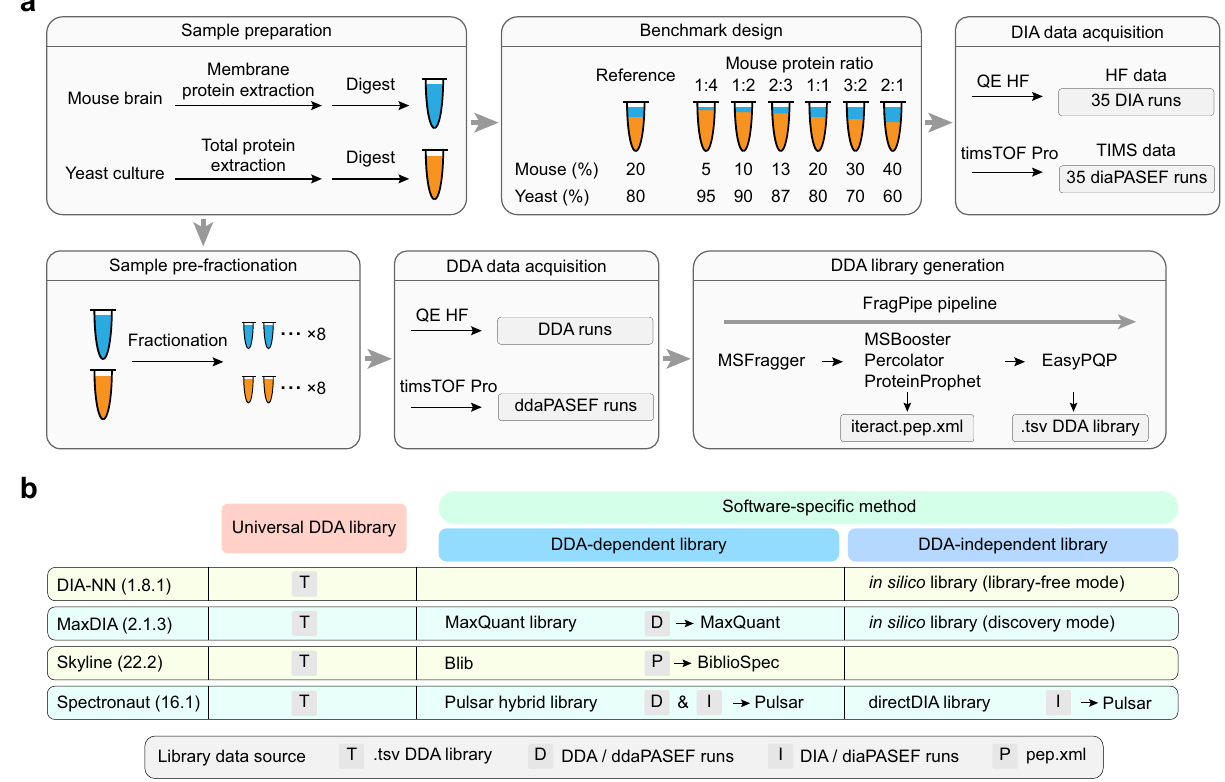
Fig. 1 | Schematic of the benchmarking experiment and DIA data analysis work fl ows.a Work fl ow of the benchmarking experiment. Mouse brain membrane protein digests were spiked into a yeast proteome background in seven de fi ned proportions, yielding one reference and six mixtures with fi xed mouse protein ratios relative to the reference. For each sample prepared in fi ve replicates, DIA benchmarkdatawereacquiredonQEHFandtimsTOFProinstruments.Meanwhile DDA data were acquired on two instruments from pre-fractionated samples